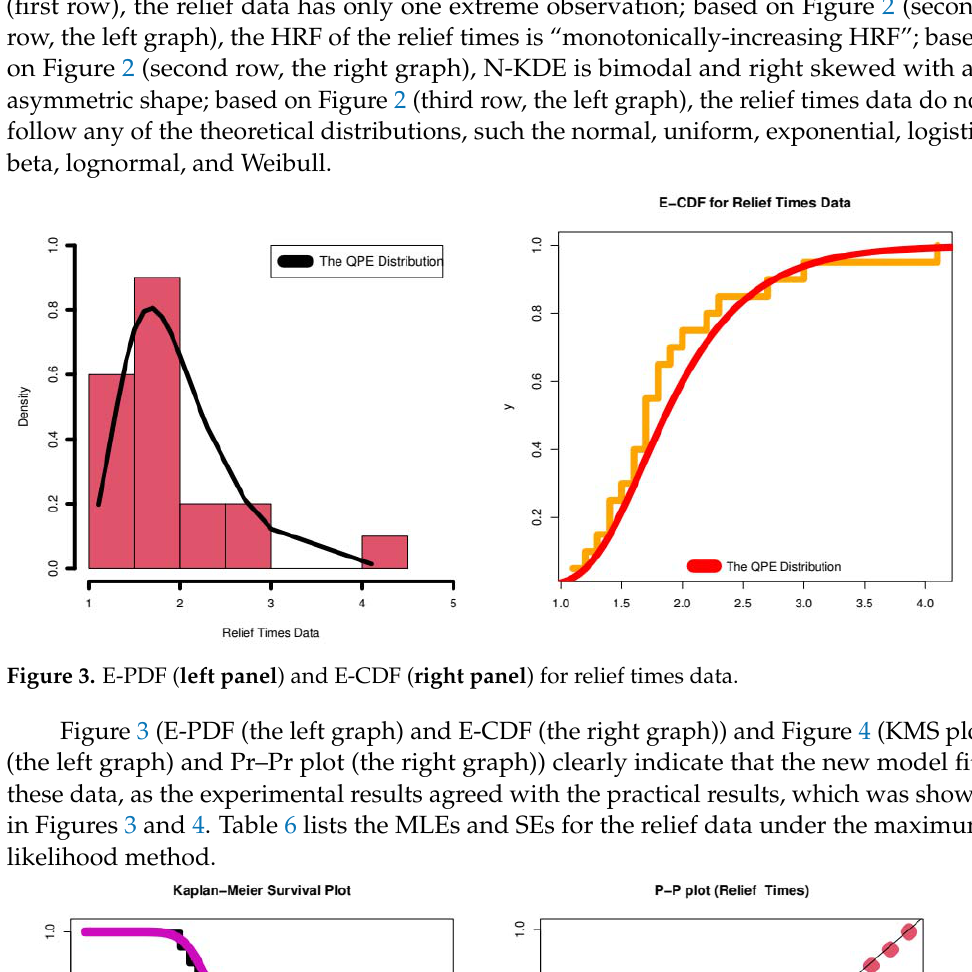
Figure 3. E ‐ PDF ( left panel ) and E ‐ CDF ( right panel ) for relief times data.